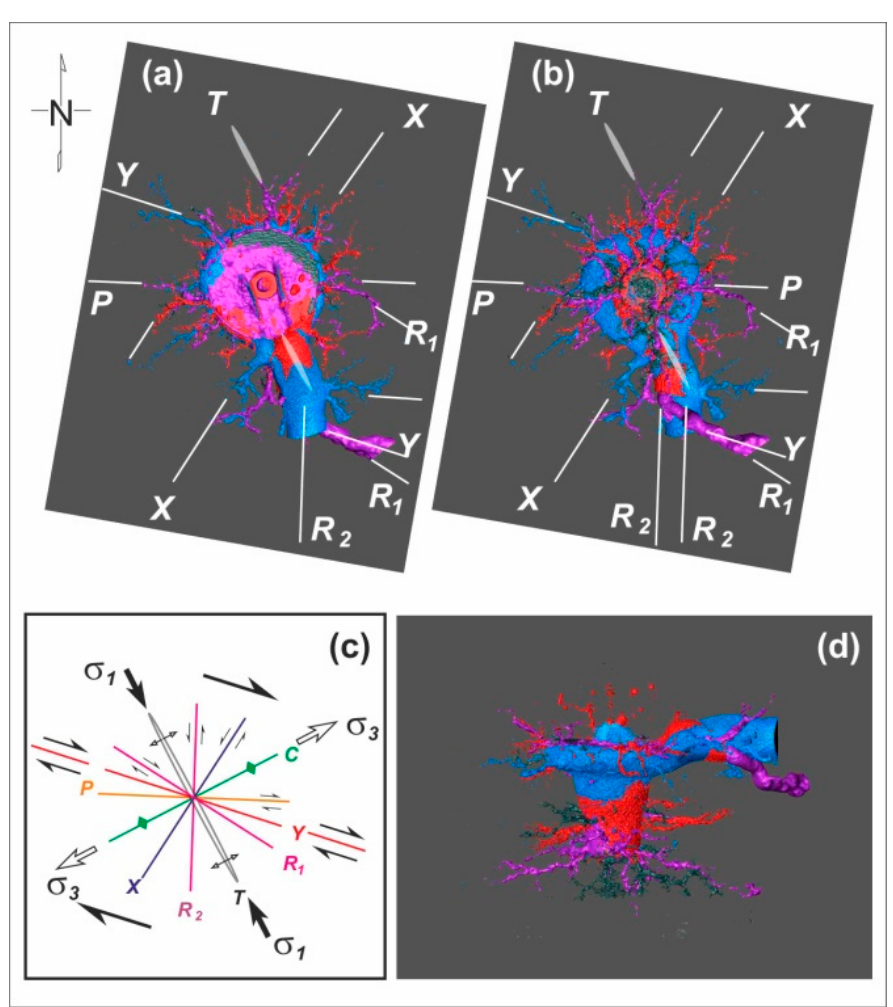
Figure 8. Azimuthally referenced structural control of dissolution arrays and principal wormhole morphology derived from the results of a spatial comparison of the experimental results: #1 (shown in grey), #2 (shown in purple), #3 (shown in red), #4 (shown in blue) in the framework of depicted orientations of fractures ( c ) appeared to be pronounced in the original sample of Lavoux limestones: ( a ) top view; ( b ) bottom vertically mirrored view; and ( d ) side 3D view.